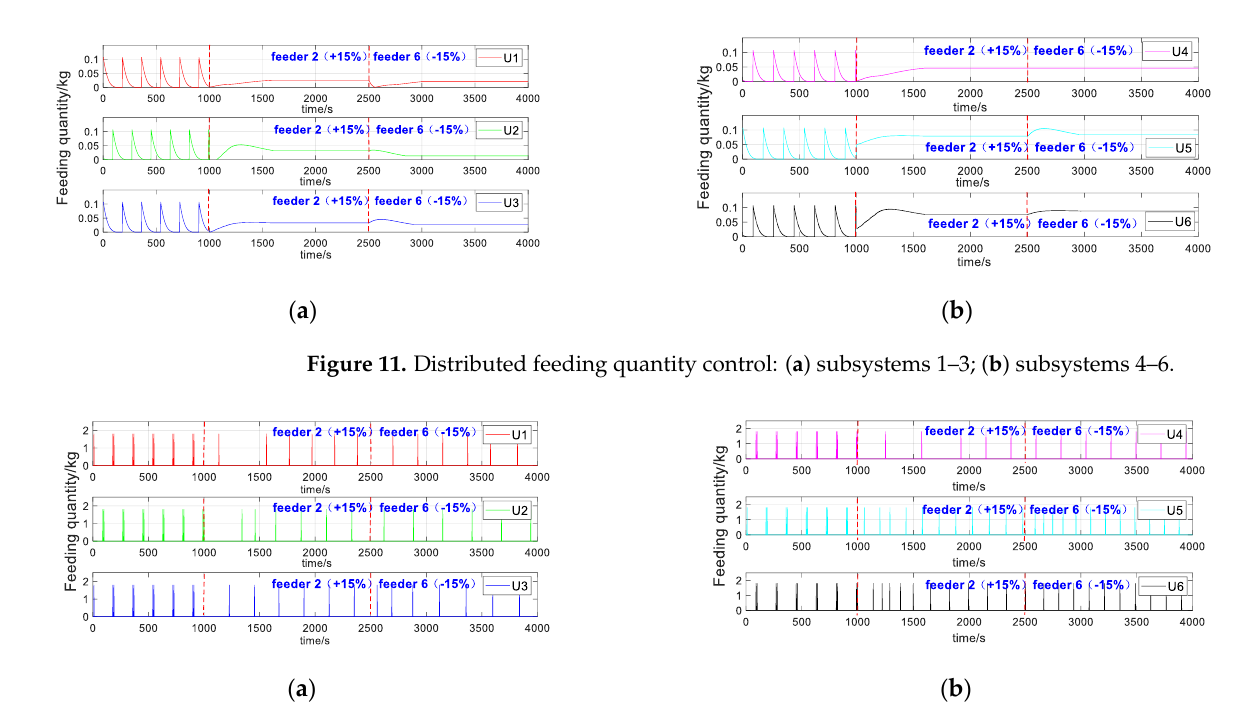
Figure 12. Distributed feeding interval control: ( a ) subsystems 1 – 3; ( b ) subsystems 4 – 6.